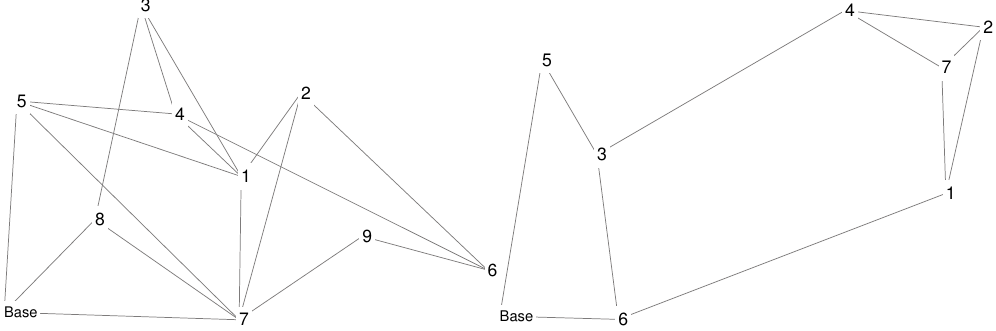
Figure 2. Visualization with base, UGSs and roads of Scenario A ( left ) and B ( right ). Table 1. Base and unattended ground sensor (UGS) parameters for Scenarios A and B. Scenarios